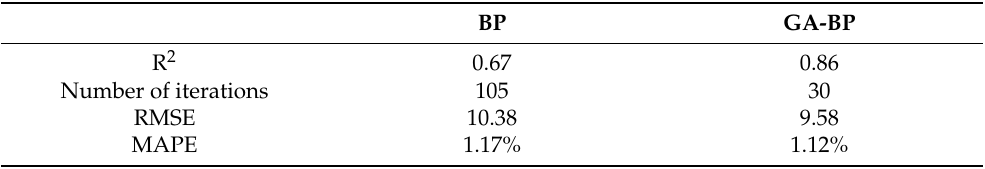
Figure 14. Statistics of glacier deformation zoning in the Meili Snow Mountain.